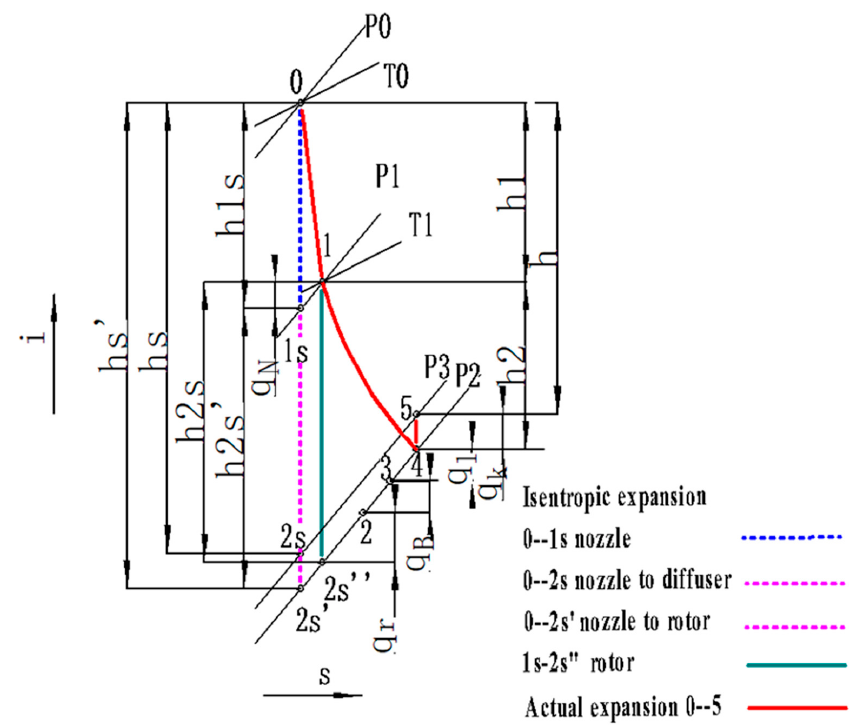
Figure 3. Turbine thermodynamic process enthalpy and entropy change diagram.